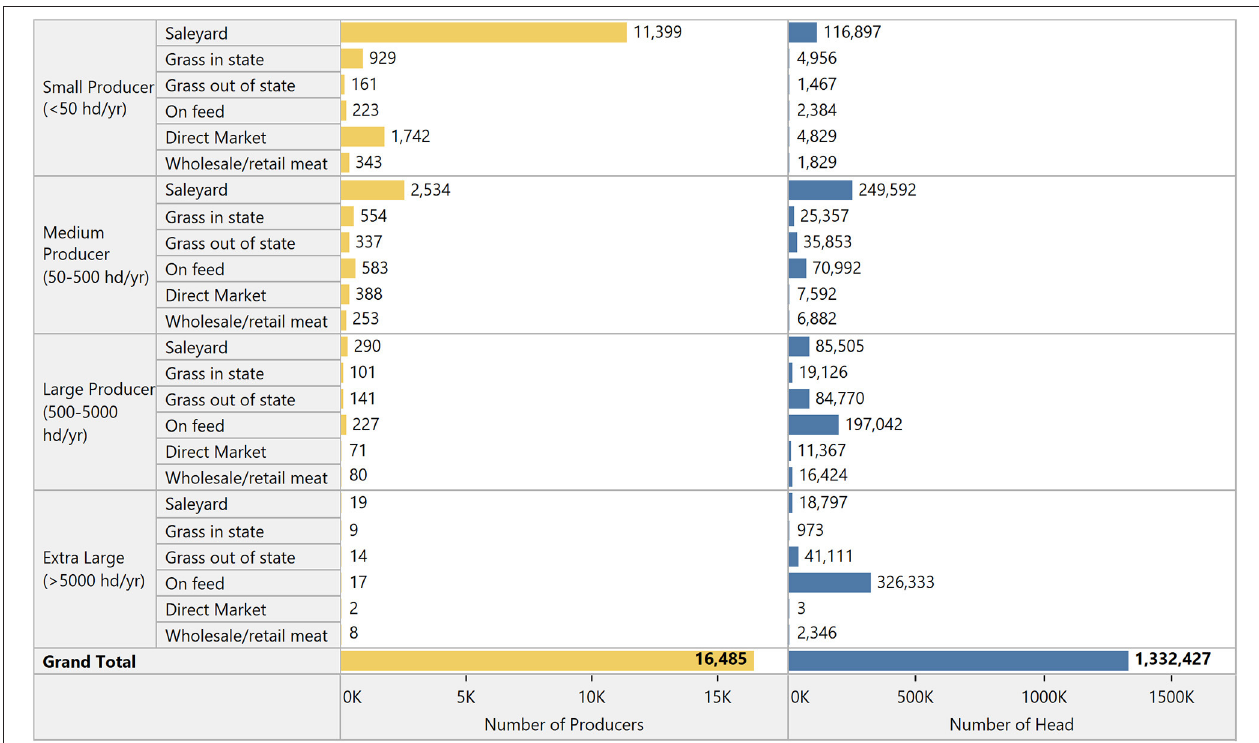
FIGURE 5 | Movements of beef cattle in California by size of ranch producer and destination from grazing land (2017). Size is based on total number of head but producers may use more than one type of movement.